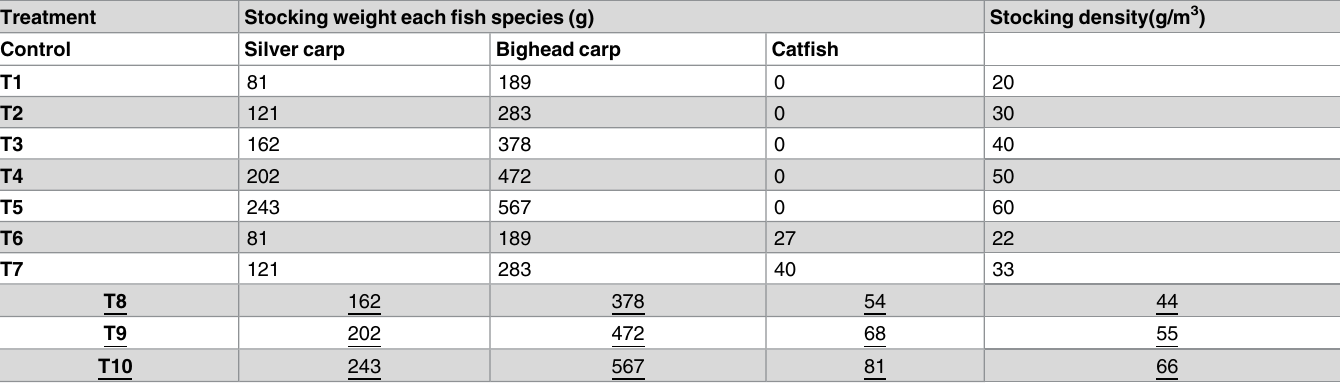
Table 1. Experimental designs for different treatments. Treatment Stocking weight each fish species (g) Stocking density(g/m 3